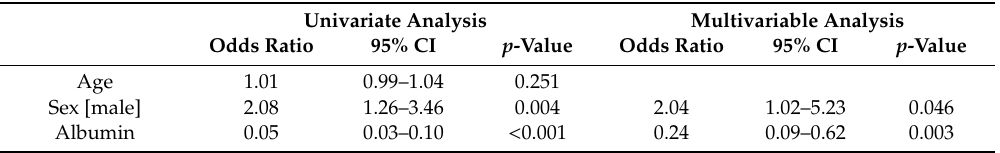
Table 2. Univariate and multivariate regression analyses of the clinical and laboratory parameters for predicting advanced